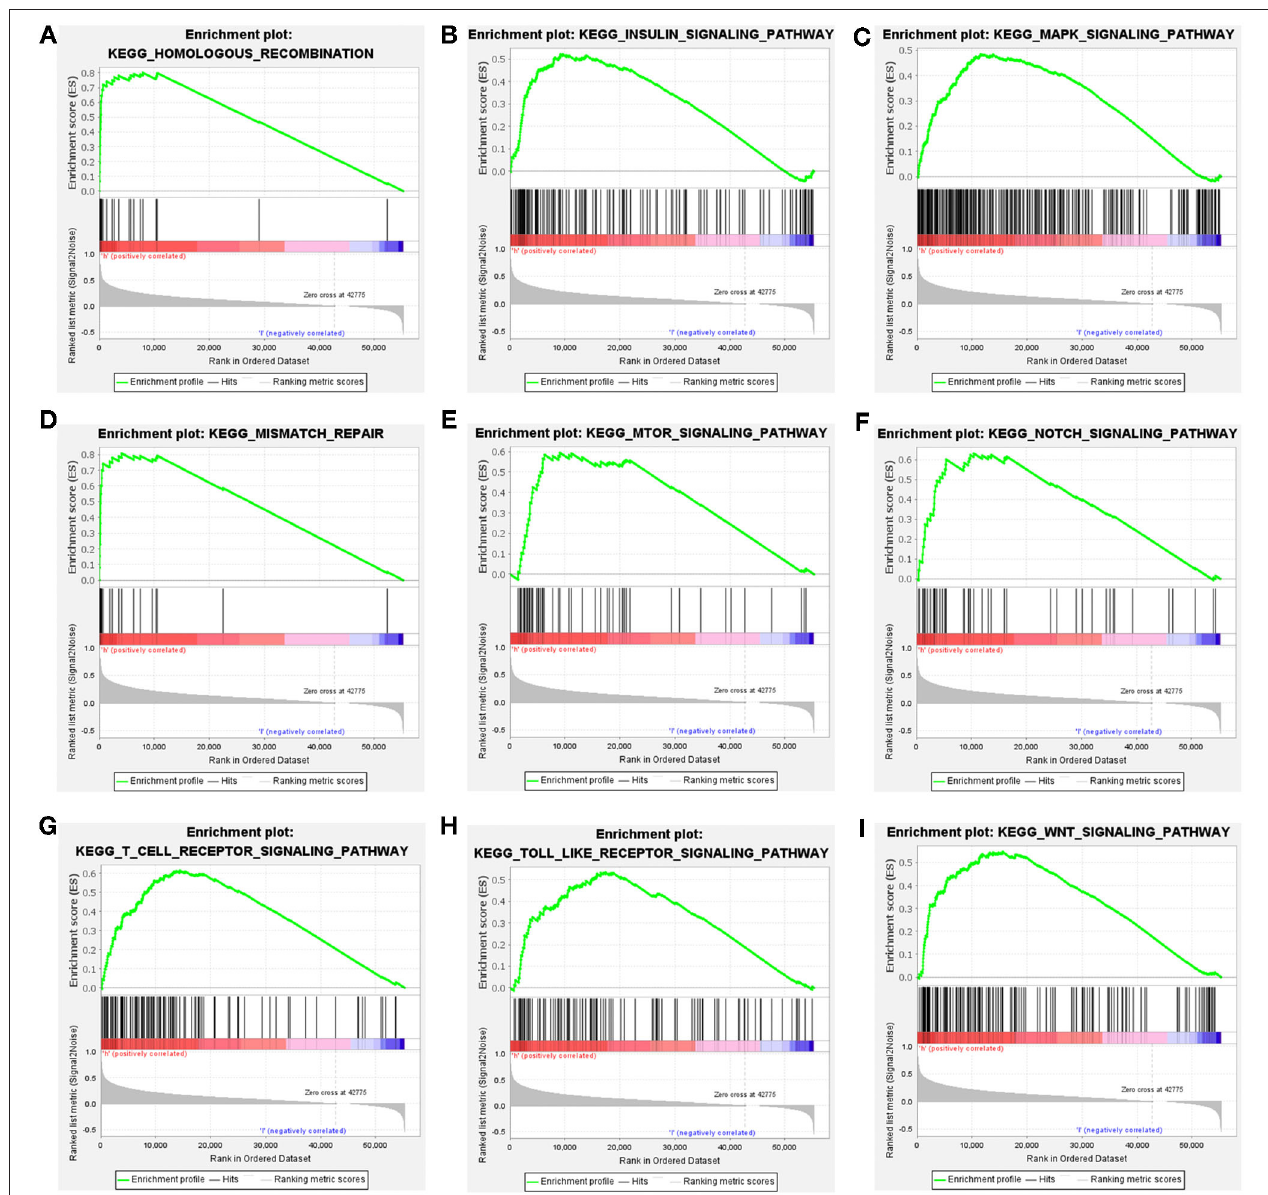
FIGURE 4 | Cell division cycle-associated protein 2-related pathways identified by gene set enrichment analysis (GSEA). (A) Homologous recombination pathway, (B) insulin signaling pathway, (C) MAPK pathway, (D) mismatch repair pathway, (E) mTOR pathway, (F) Notch pathway, (G) T cell receptor pathway, (H) toll like receptor pathway, and (I) WNT